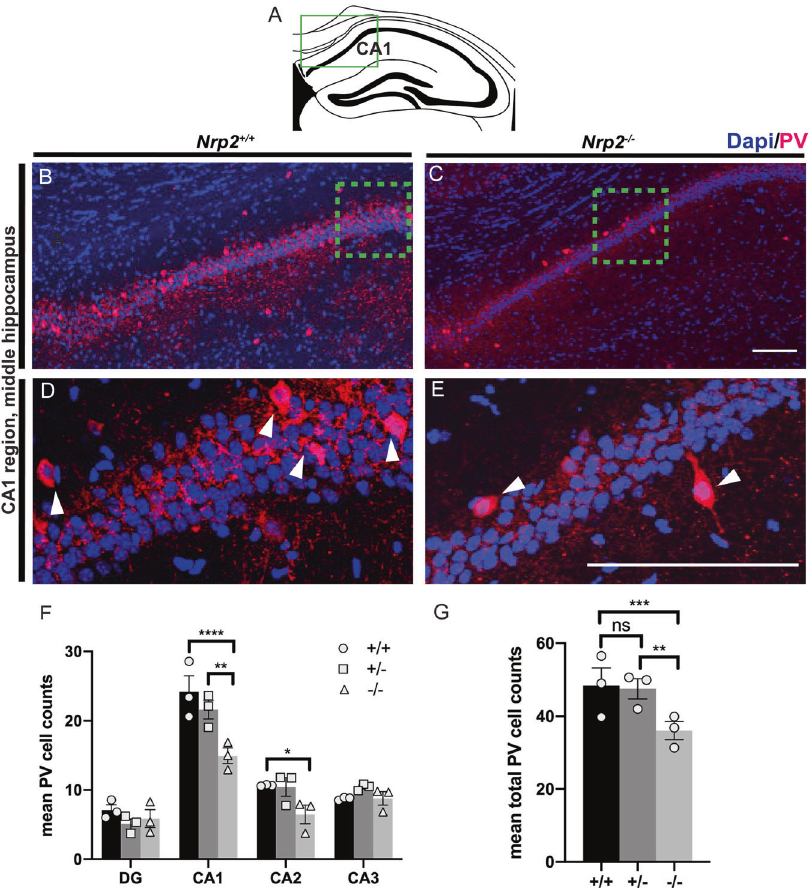
Fig. 1 Developmental deletion of Nrp2 leads to reduced numbers of parvalbumin (PV) expressing neurons in the CA1 region of the hippocampus. A Schematic of a coronal adult hippocampal section, green box indicates CA1 hippocampal region of images in B – E . B – C Immuno-labeled of Nrp2 + / + (littermate control) and Nrp2 − / − brain sections, respectively, with anti-PV (red) and DAPI (blue). D – E High magni fi cation images of green boxes in B and C , respectively. Scale bars: 100 μ m in C and E for B and D , respectively. F Quanti fi cation of the averaged number of PV + cells by hippocampal region. Signi fi cantly fewer number of PV + neurons found in CA1 region of Nrp2 − / − compared to Nrp2 + / + mice. Error bars are ± SEM; two-way ANOVA, post hoc Tukey: **** p < 0.0001 + / + vs. − / − ; ** p = 0.0012 + / − vs. − / − in CA1; * p = 0.0435 + / + vs. − / − in CA2. G Quanti fi cation of total mean PV + cells. Signi fi cantly more PV expressing neurons found in hippocampal region of Nrp2 + / + and Nrp2 + / − mice compared to Nrp2 − / − mice. Error bars are ± SEM; two-way ANOVA, post hoc Tukey: *** p = 0.0004 + / + vs. − / − ; ** p = 0.0048 + / − vs. − / − ; ns p = 0.6072. For F and G: n = 3